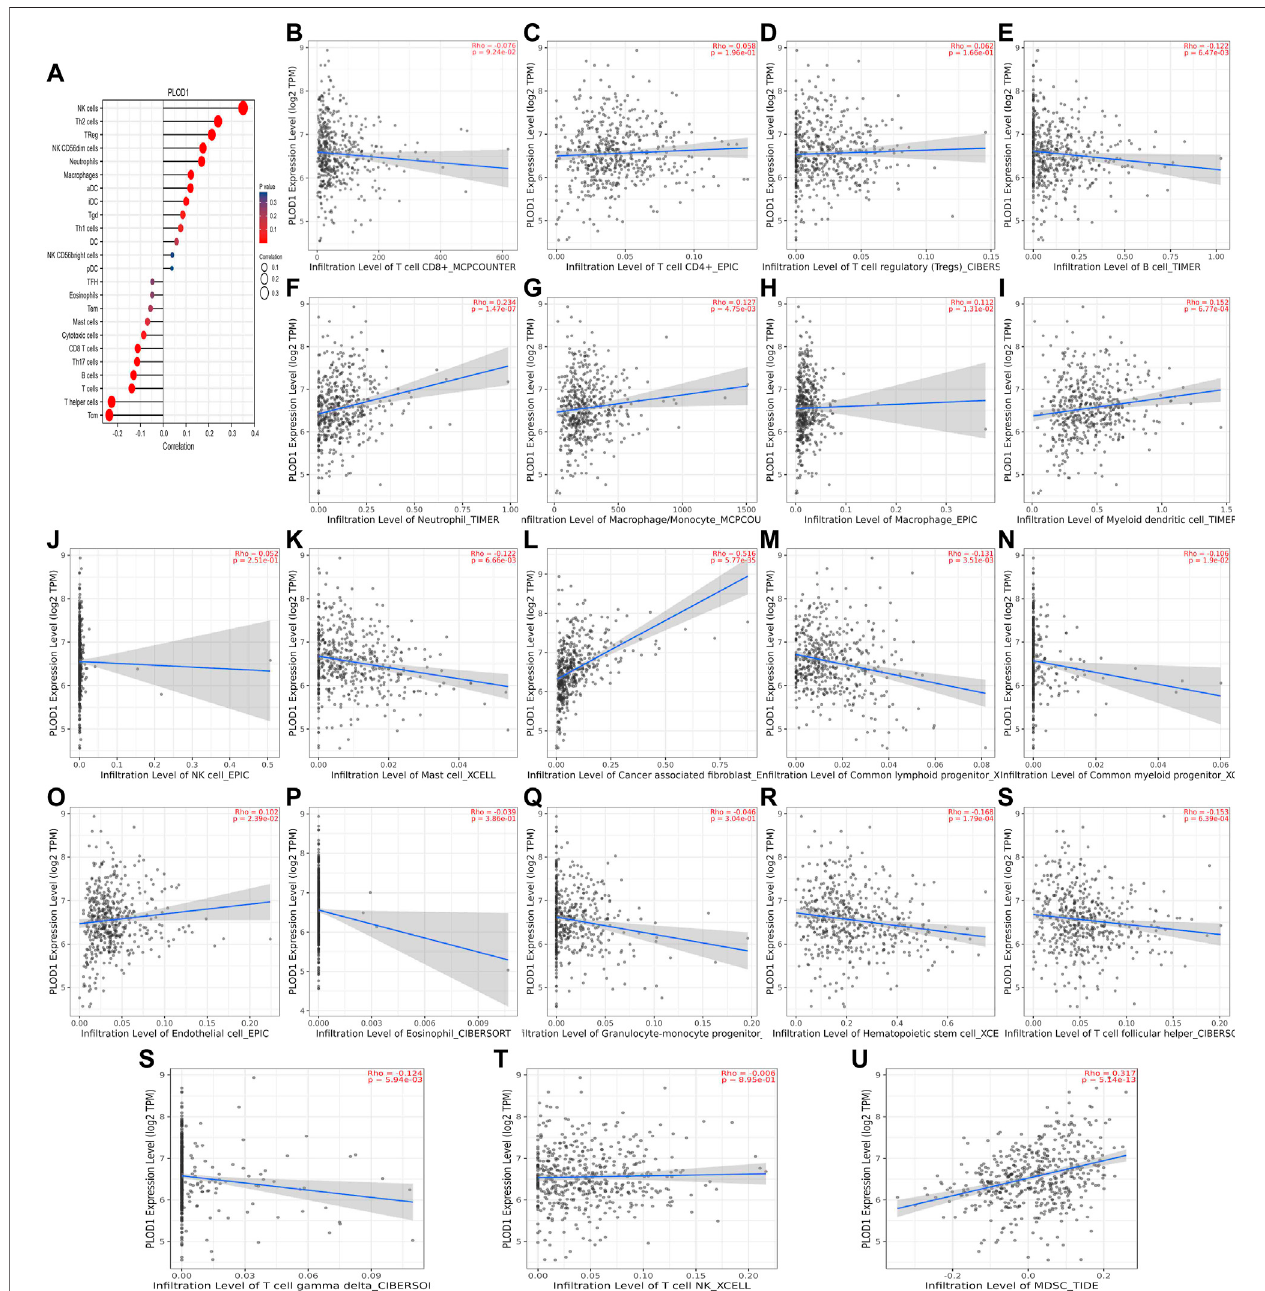
FIGURE 9 | Association between PLOD1 and immune in fi ltration. (A) Summary plot of the relationship between PLOD1 expression and immune in fi ltration. (B – U) PLOD1 expression isnegativelyrelated totumor purityand hascorrelationswithTFH, CD8 + T, TH,cytotoxic, mast, and Bcells;on thecontrary,itispositivelycorrelated with Tregs, macrophages, and cancer-associated fi